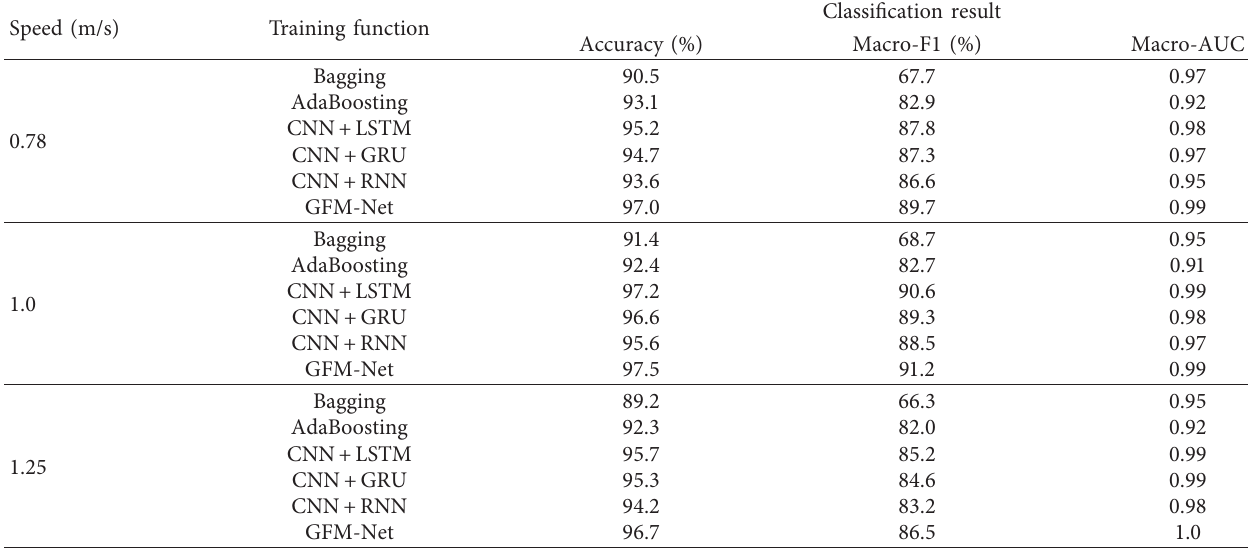
Table 2: Summary of classification performance for different training functions.